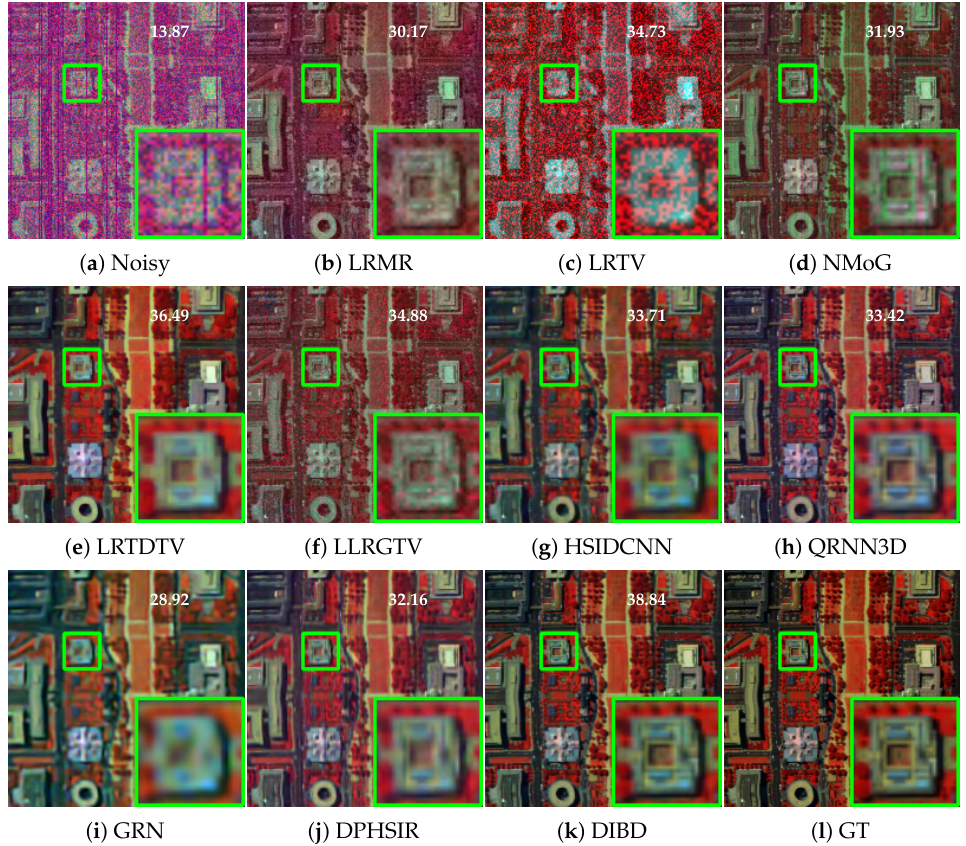
Figure 6. Denoising results (PSNR, dB) and visual comparisons of the image from the Washington DC dataset under complex noise of case 5. The RGB image is synthesized by HSI bands 78, 45,